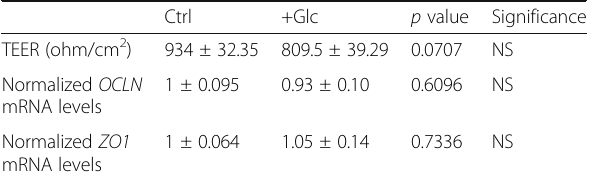
Table 1 Effect of high glucose on cell